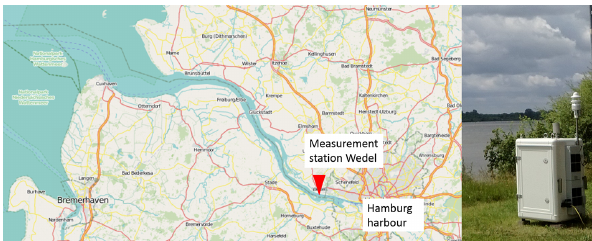
Figure 1. Location of the measurement station on the northern bank of the river Elbe, near Hamburg harbour. On the right: picture of instrument box. Map source: